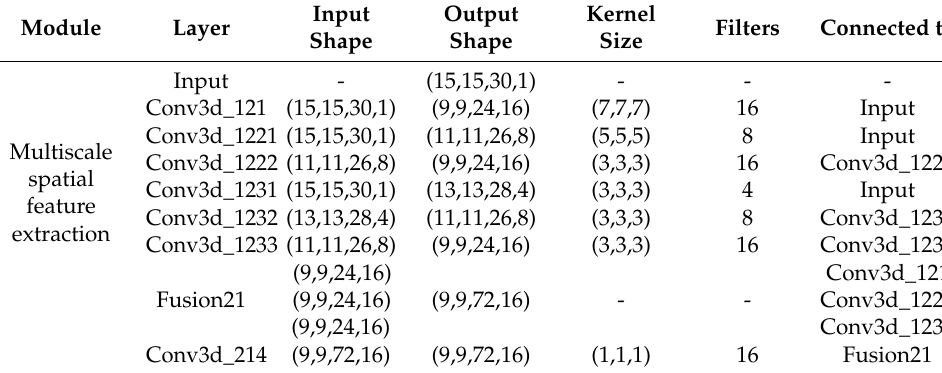
Table 2. The implementation details of the multiscale spatial feature extraction module.